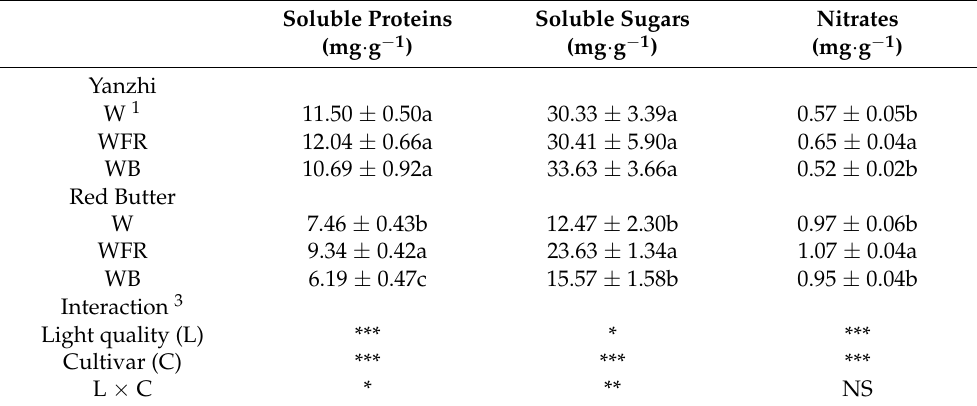
Table 7. Effects of different light quality on nutritional compound contents in lettuce. Soluble